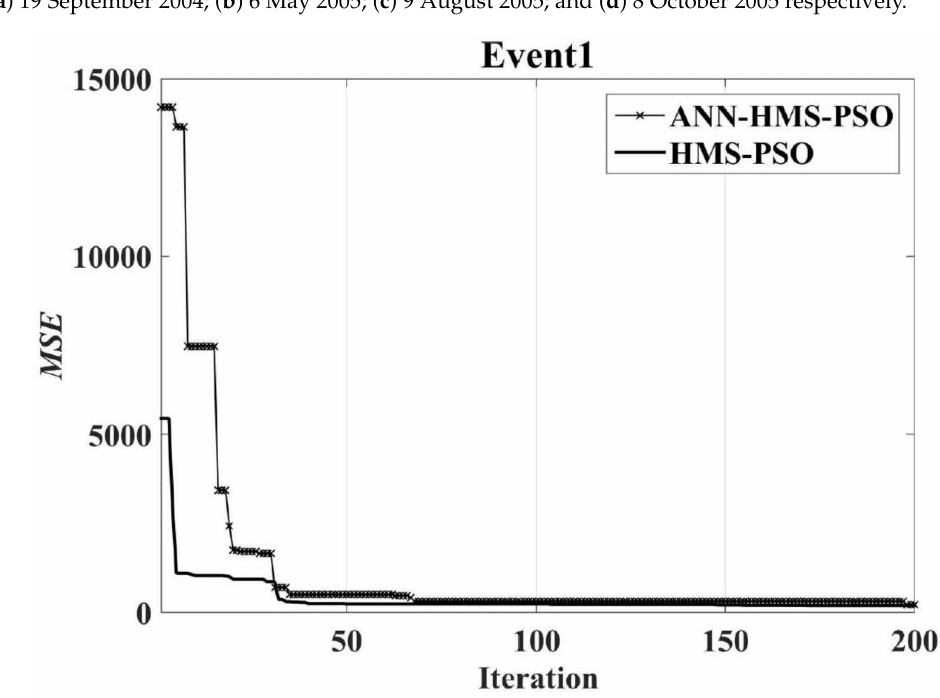
Figure 6. Convergence curve of objective function ( MSE ) for Event